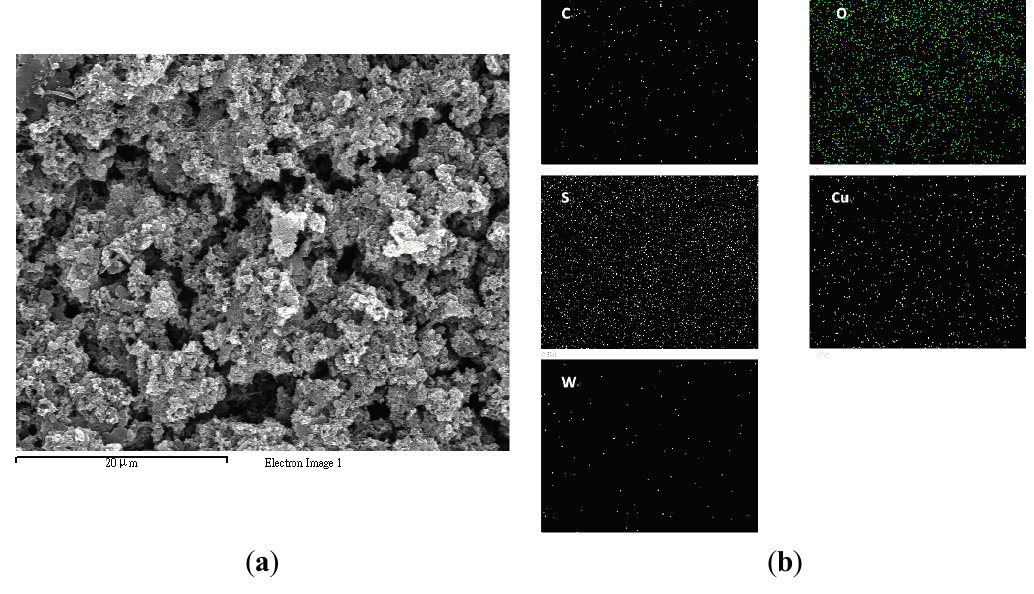
Figure 4. ( a ) SEM image of the as-synthesized sensitive layer and ( b ) the EDS mapping of various elements.